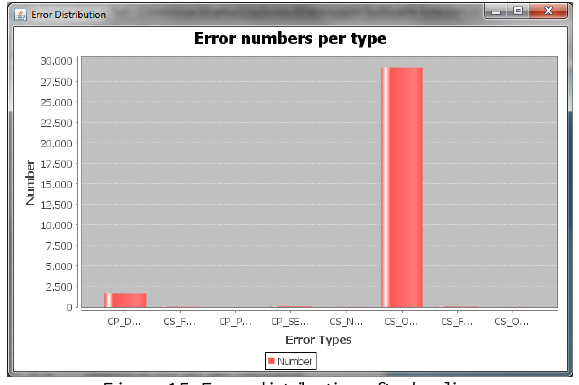
Figure 15. Error distribution after